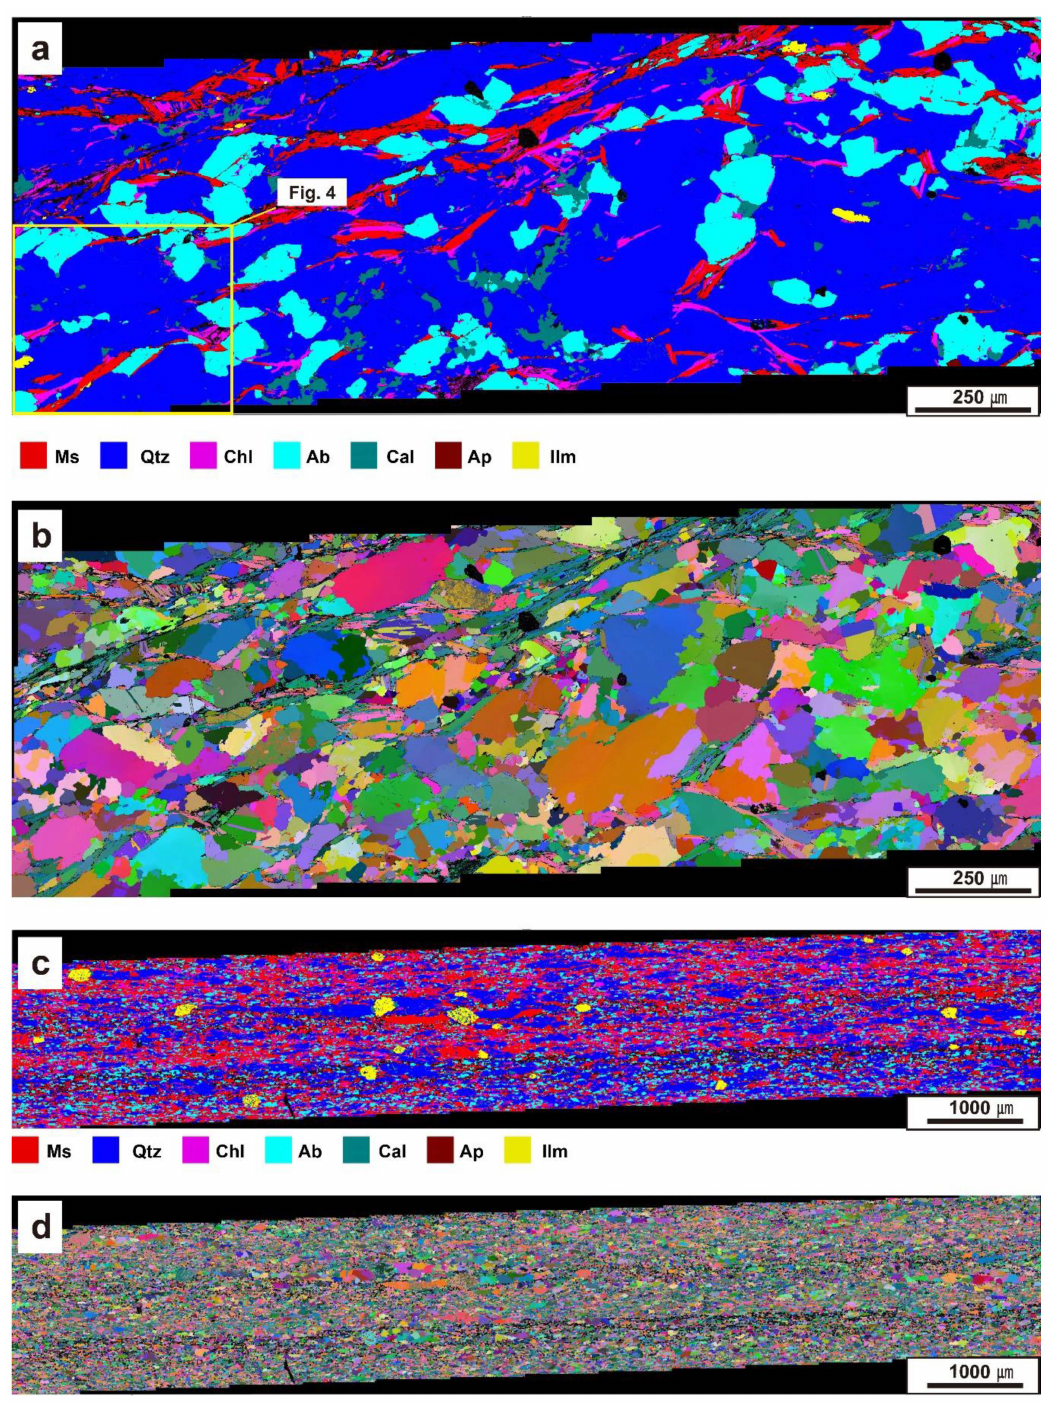
Figure 3. EBSD phase maps ( a , c ), and Euler maps ( b , d ) of phyllite samples. ( a , b ) Sample G105 analyzed with step size of 0.31 µ m. ( c , d ) Sample G102 analyzed with step size of 5 µ m. Magnified EBSD map of the yellow box in Figure 3a is shown in Figure 4. Ms: muscovite, Qtz: quartz, Chl: chlorite, Ab: albite, Cal: calcite, Ap: apatite, Ilm: